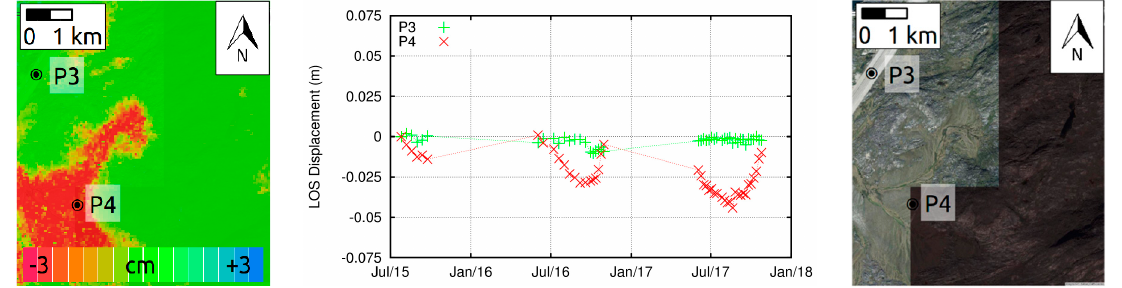
Figure 7. Time series of displacement in the line ‐ of ‐ sight direction over the airport strip (P3) and on peat terrain underlain by fine ‐ grained marine sediments (P4) within the Ilulissat site. For location see Figure 5. Map data are from Google, DigitalGlobe.